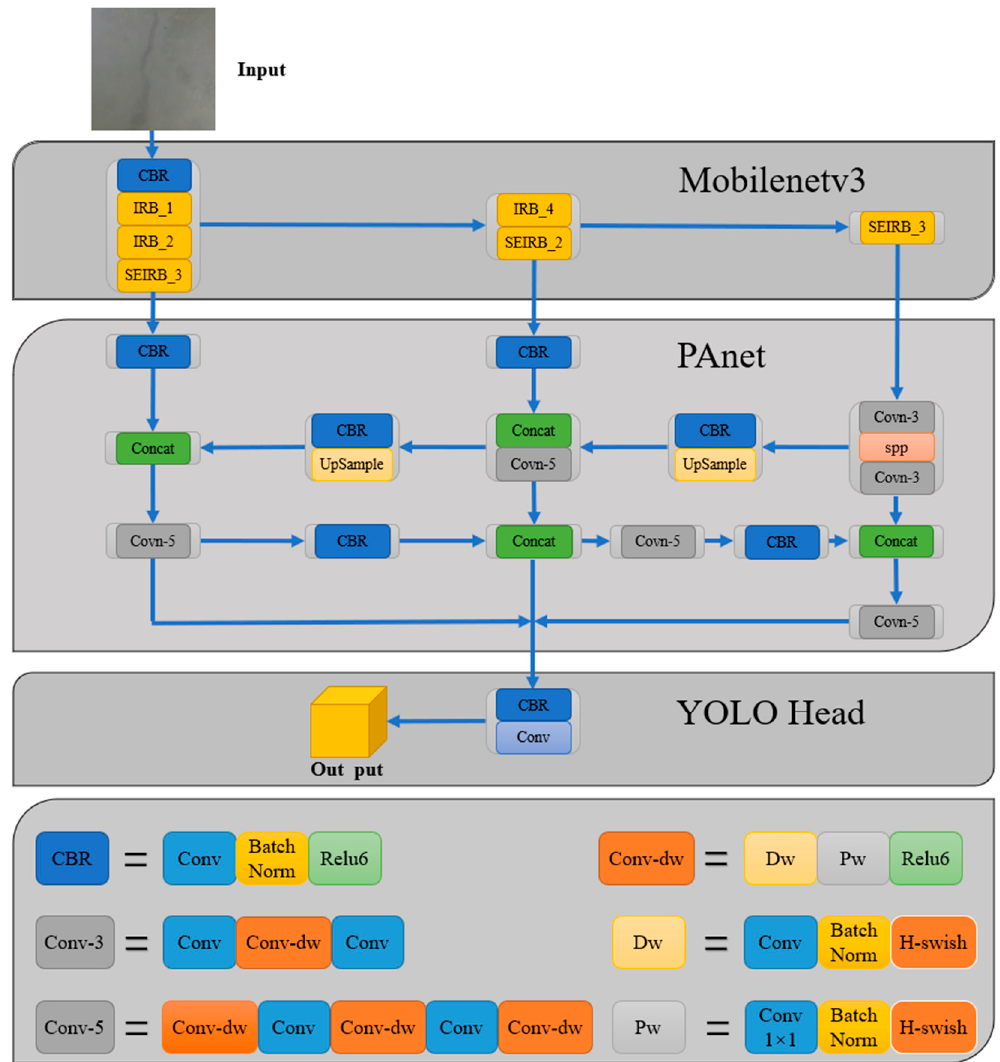
Figure 5. Structure of the Lite-YOLO-v4 Crack Detection Algorithm.